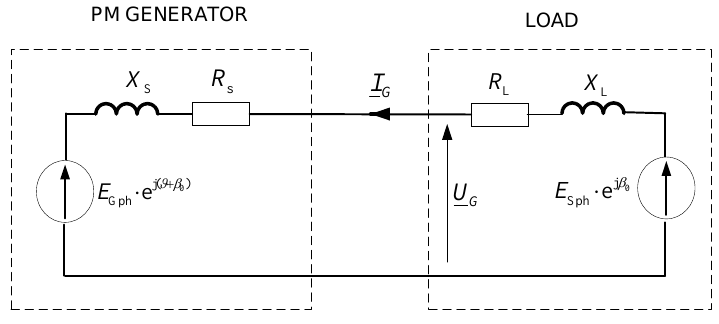
Figure 15. Simplified equivalent phase generator diagram.